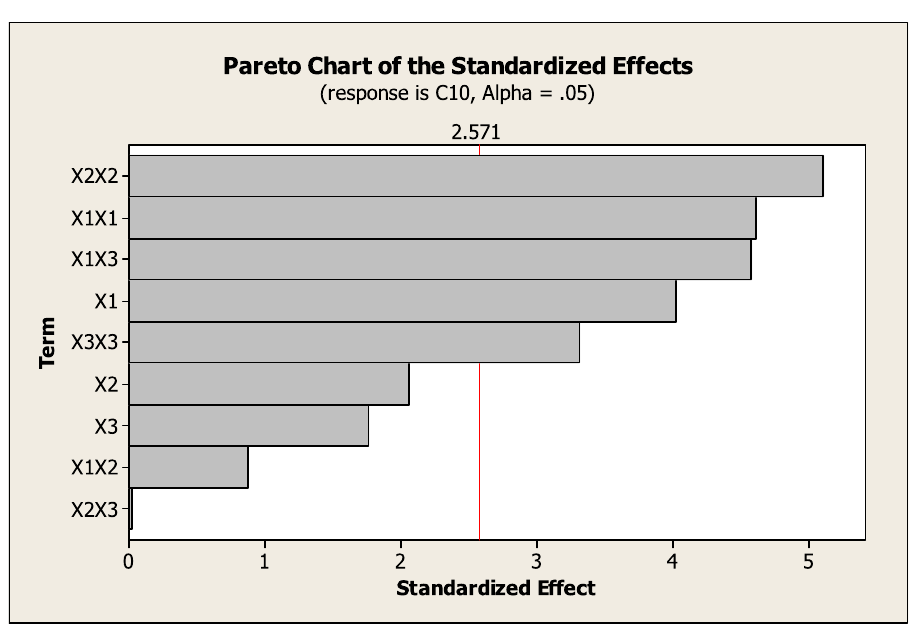
Figure 2. A Pareto chart illustrating the main effects of Box-Behnken result, with the order of significance of the variables affecting Alk-ZnO NPs size. Bars that exceed the vertical line indicate the significance of the terms ( P <